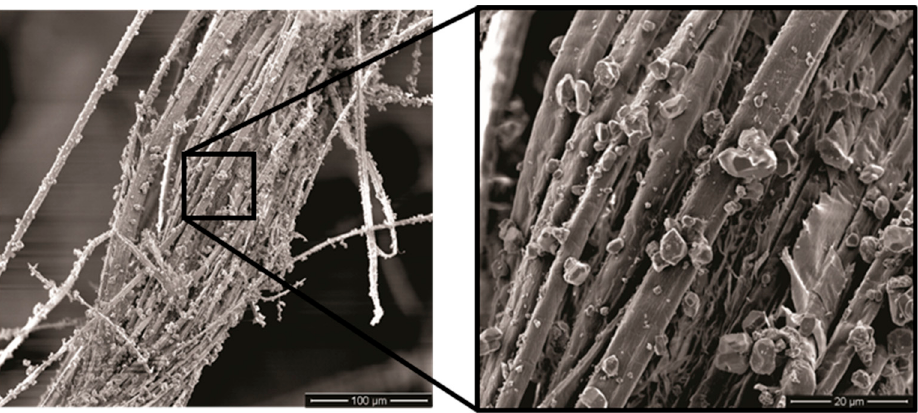
Figure 15. Curaua fiber covered with ceramic Figure 15 . Curaua fiber covered with ceramic fragments. Figure 15 . Curaua fiber covered with ceramic fragments.